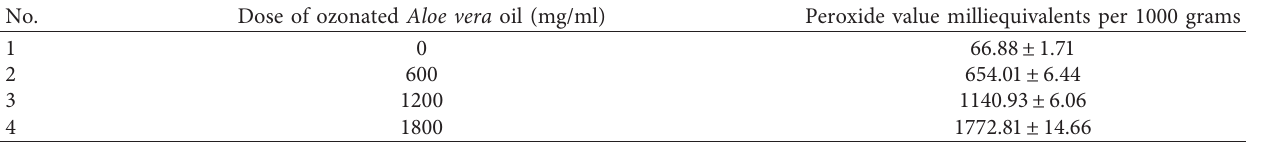
Table 1: Results of calculation of the peroxide value based on the dose of ozonated Aloe vera oil. No.